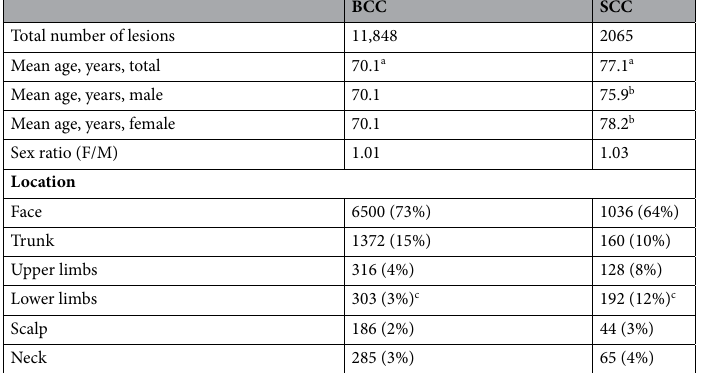
Table 2. Clinical characteristics of patients with BCC and SCC. BCC basal cell carcinoma, SCC squamous cell carcinoma, F/M female to male ratio. a The mean age of patients differed significantly between SCC and BCC patients ( p < 0.01). b The mean age of SCC patients differed significantly between men and women ( p < 0.01). c SCC was significantly more common on the lower limbs than BCC ( p <